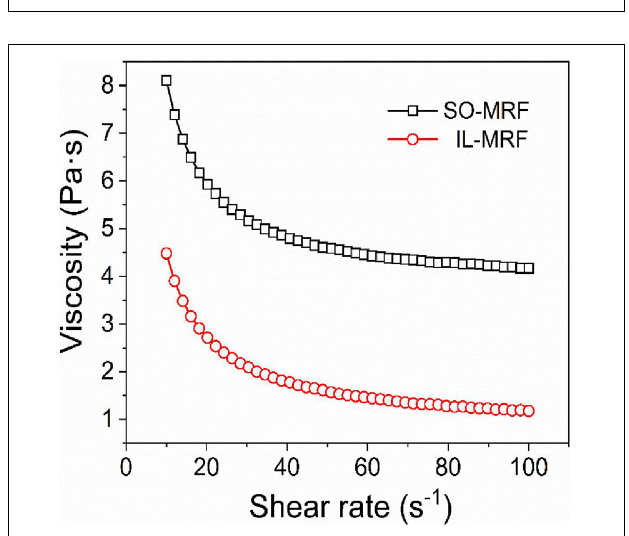
FIGURE 2 | Dependence of viscosity of SO-MRF and IL-MRF on shear rate at zero field.